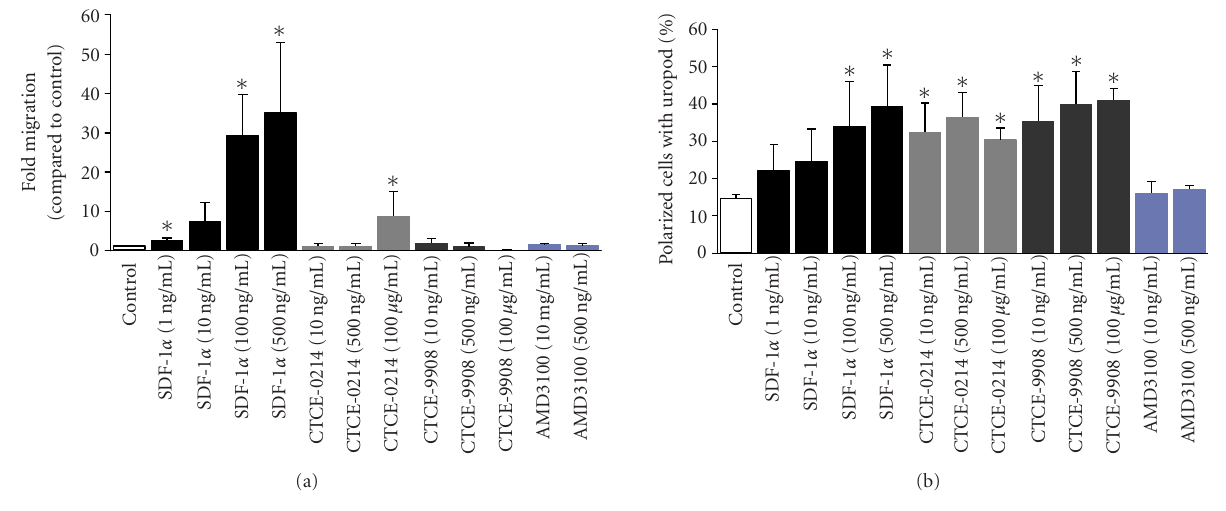
Figure 2: E ff ects on cell migration and podia formation.The e ff ect of the SDF-1 α , CXCR4 agonist, and CXCR4 antagonists on migration of human CD34 + cells was assessed in transwell migration experiments. The fold increase in migration upon treatment with these compounds was determined in relation to the corresponding control in four to eight independent experiments. SDF-1 α induced chemoattraction in a dose-dependent manner. The same concentration of the peptide agonist CTCE-0214 and the peptide antagonist CTCE-9908 did not have any significant e ff ect on migration of CD34 + cells although there was a significant e ff ect using much higher concentrations of CTCE-0214. (a) ∗ P < . 05. SDF-1 α has a dose-dependent e ff ect on the polarization and podia formation of CD34 + cells. The morphology was analyzed in five independent experiments with simultaneous comparison of the compounds. The peptide agonist CTCE-0214 and the peptide antagonist CTCE-9908 also showed a significant e ff ect on uropod formation. (b) ∗ P < .